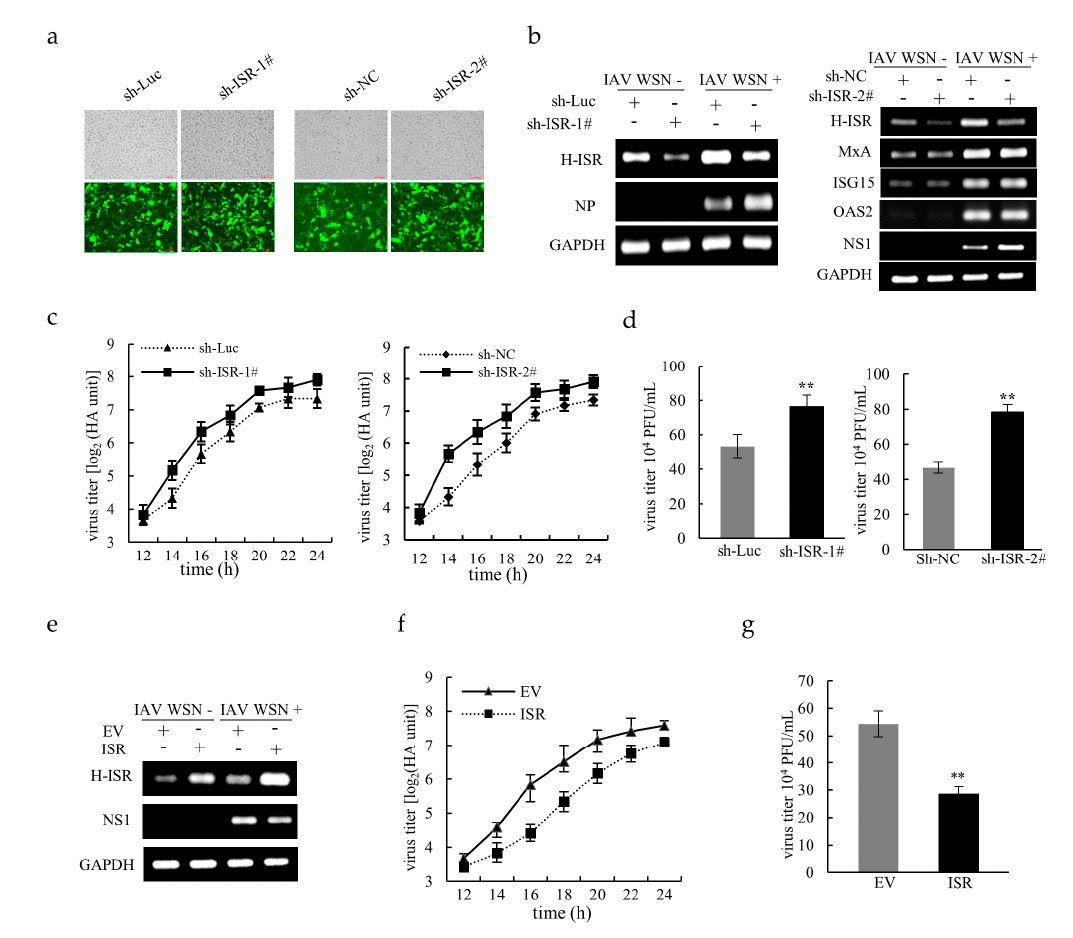
Figure 3. LncRNA ISR suppresses IAV replication. ( a ) Optical and their corresponding fluorescence images of A549 cells stably expressing pSIH-H1-GFP vectors targeting lncRNA ISR or luciferase control (Luc) or scramble nucleotide sequences (NC) (100 µ m); ( b ) The A549 cells expressing two di ff erent sequences of lncRNA ISR-silencing shRNAs (sh-ISR-1# and sh-ISR-2#) or sh-Luc or sh-NC were infected with or without IAV WSN [MOI = 0.8 (left) MOI = 0.4 (right)] for 16 h. After infection, total RNA was extracted for RT-PCR to detect lncRNA ISR or ISGs (MxA, ISG15 and OAS2) expression. RT-PCR for detecting viral NP or NS1 was performed to indicate the extent of viral replication. The cell culture supernatants were harvested at the indicated times for hemagglutination assay ( c ) and at 14 hpi for plaque assay ( d ) to measure virus titers. Data are represented as mean ± S.D. ** p < 0.01; ( e ) The A549 cells carrying either lncRNA ISR-expressing plasmid or EV were infected with or without IAV WSN (MOI = 0.4) for 16 h. After infection, total RNA was extracted for RT-PCR to detect lncRNA ISR expression. The cell culture supernatants were harvested at the indicated times for hemagglutination assay ( f ) and at 16 hpi for plaque assay ( g ) to measure virus titers. Data are represented as mean ± S.D. ** p < 0.01.